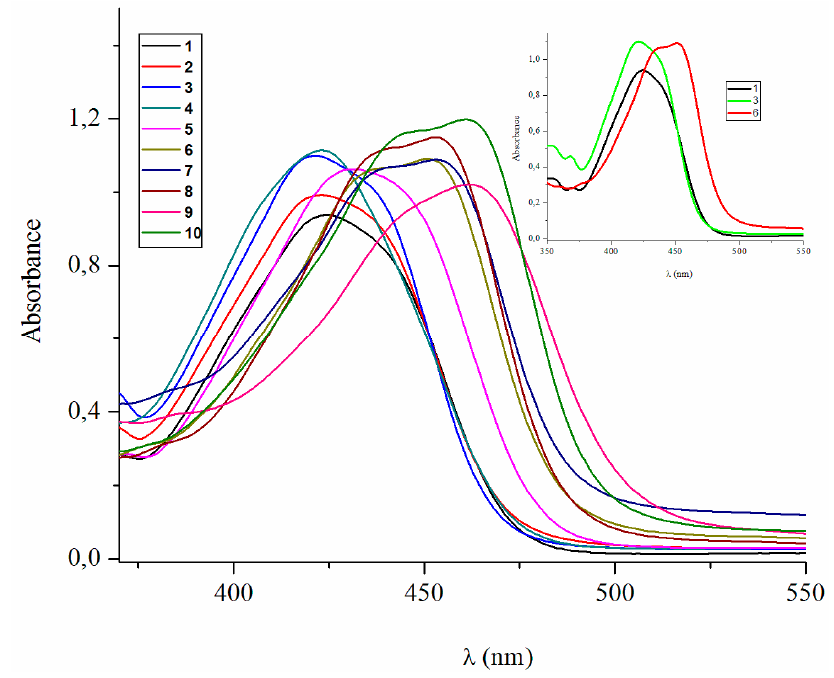
Figure 1. Visible absorption spectra of azulene ‐ chalcone derivatives 1 – 10 in dichlorome t hane.